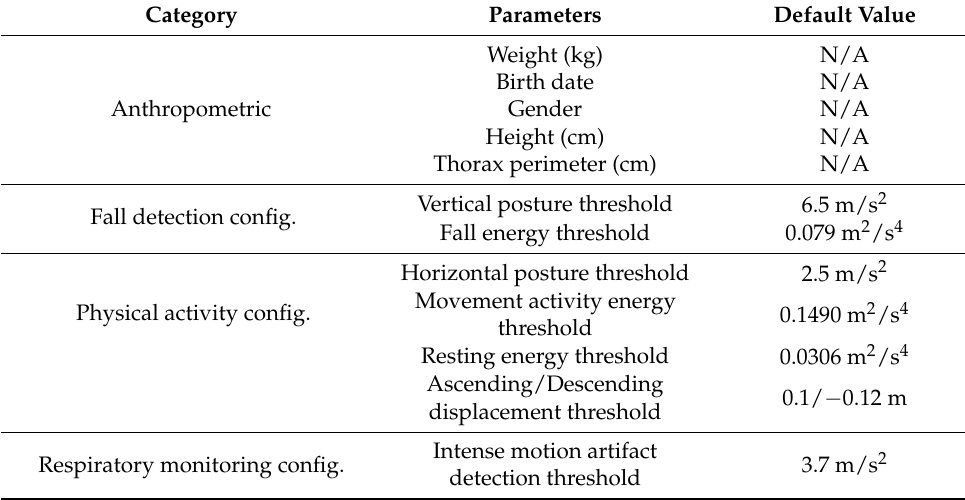
Table 2. API personalization parameters.